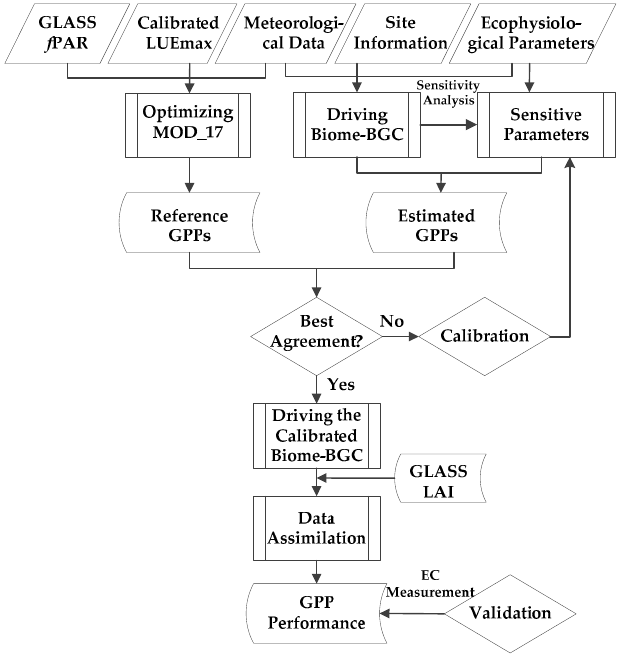
Figure 1. The overall flowchart of this study.